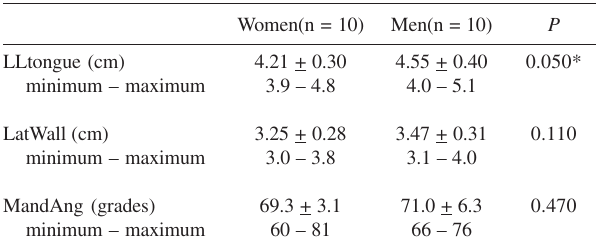
Table 2 - Axial pharyngeal measurements in healthy men and women